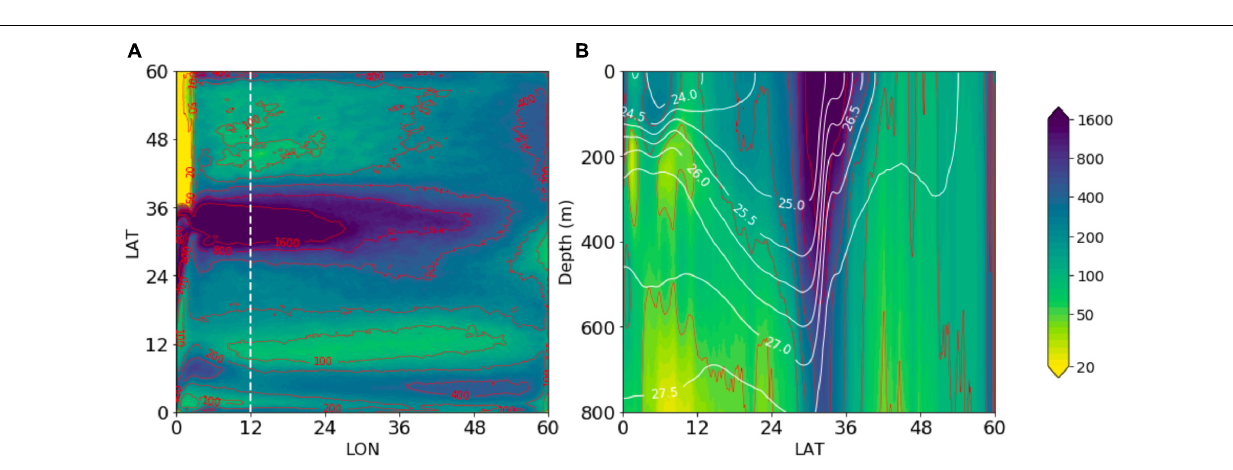
FIGURE 6 | Spatial distribution of the EKE (in cm 2 s − 2 ) in D32. (A) The surface map. (B) The meridional section along 12 ◦ E, overlaid by the density field (white